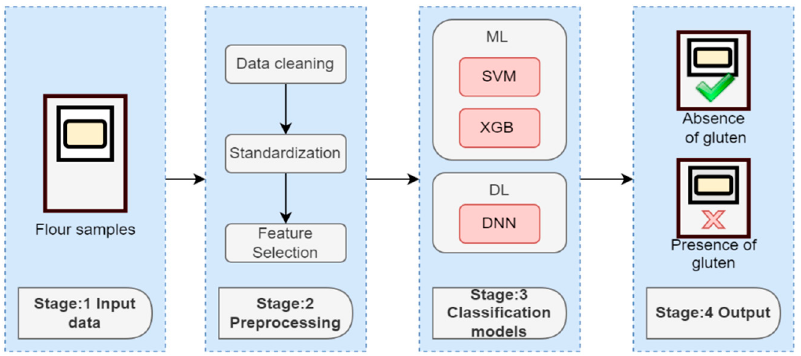
Figure 2. Hardware and software